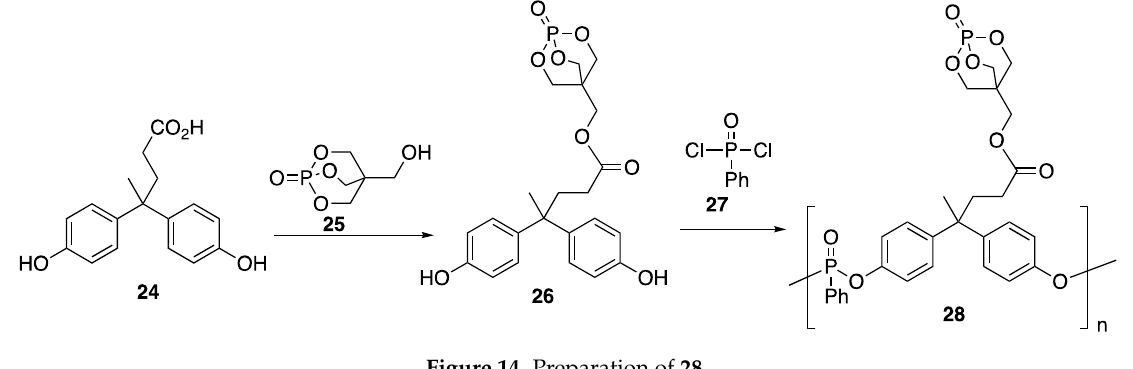
Figure 14. Preparation of 28 .